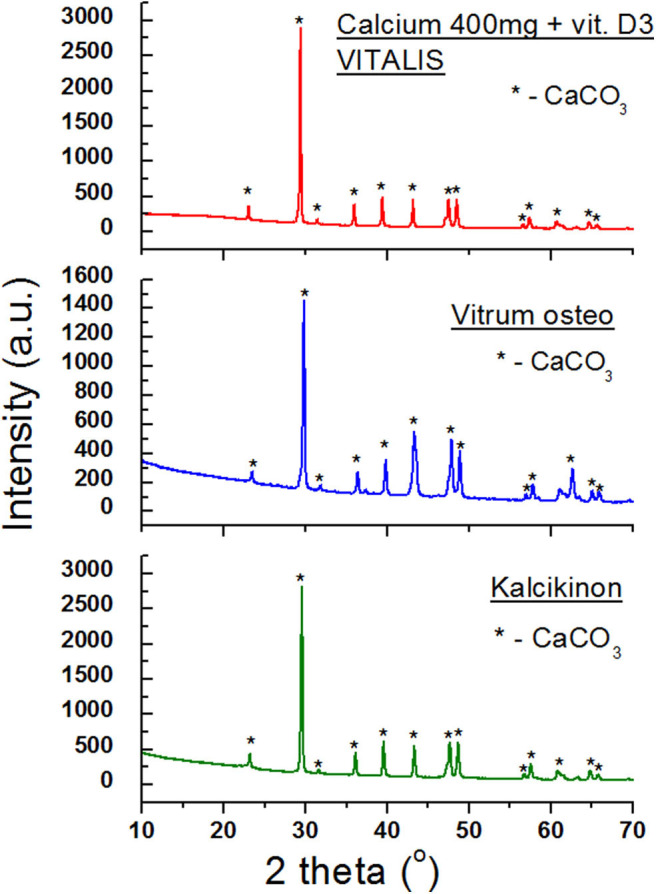
X-ray diffraction patterns for dietary supplements containing calcium carbonate CaCO3.